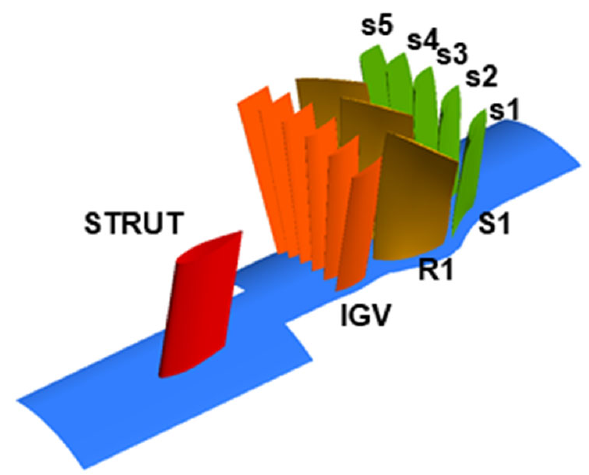
Figure 1. Geometry model of the compressor.